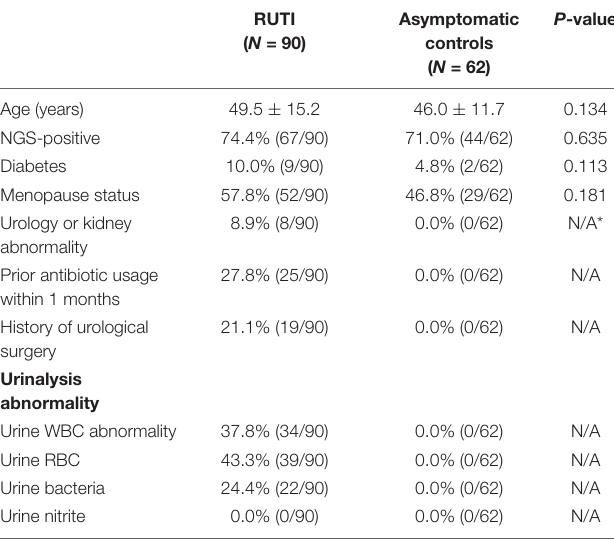
TABLE 1 | The demographic characteristics of included patients with RUTI and asymptomatic